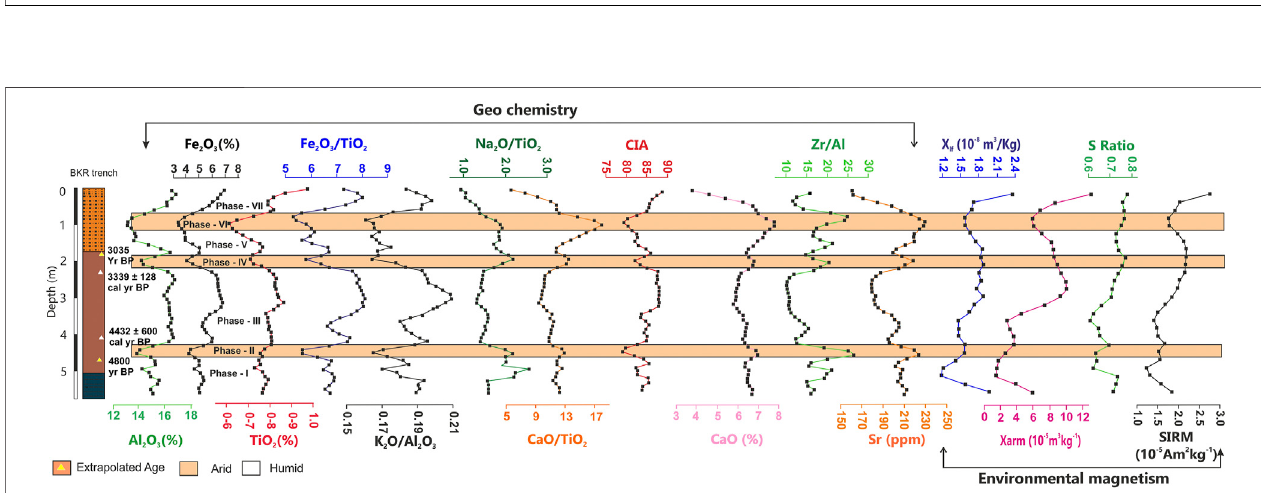
FIGURE 4 | Temporal variation of major elements, their ratios, and mineral magnetic properties from the BKR sediments of Banni Plains, GRK.